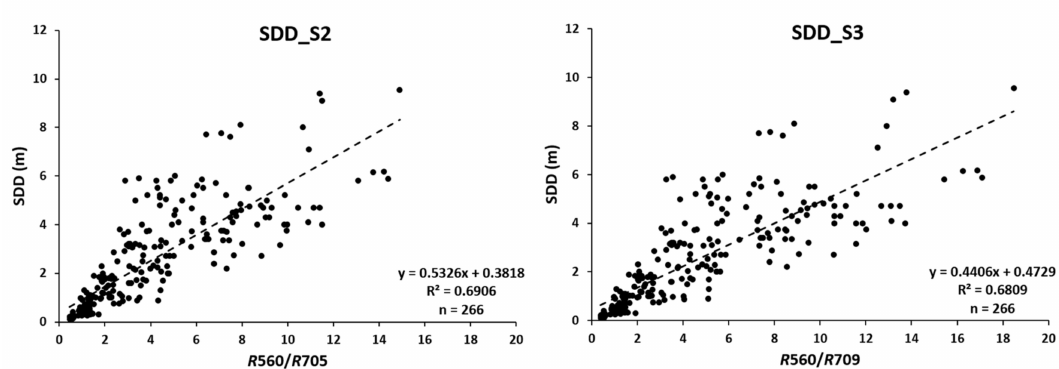
Figure 4. SDD algorithms recalculated using all